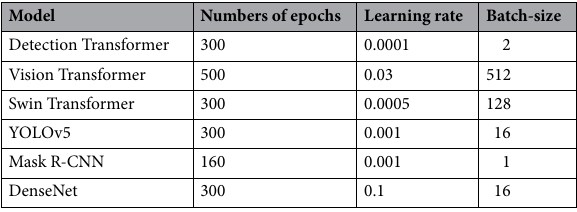
Table 4. Parameter settings of the six computer vision